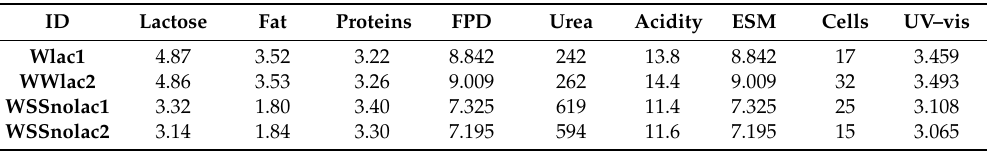
Table 2. Chemical parameters measured in milks.